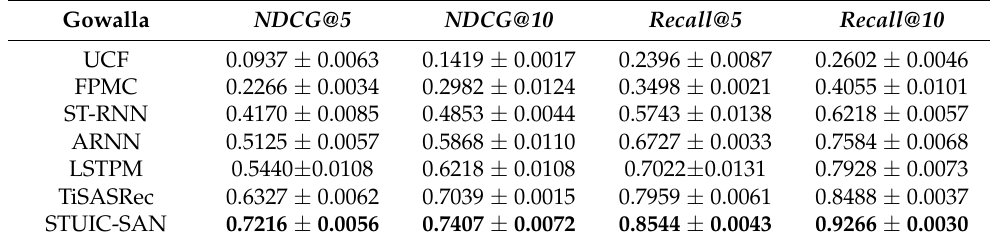
Table 6. Comparison of recommendation performance on Gowalla (mean ±